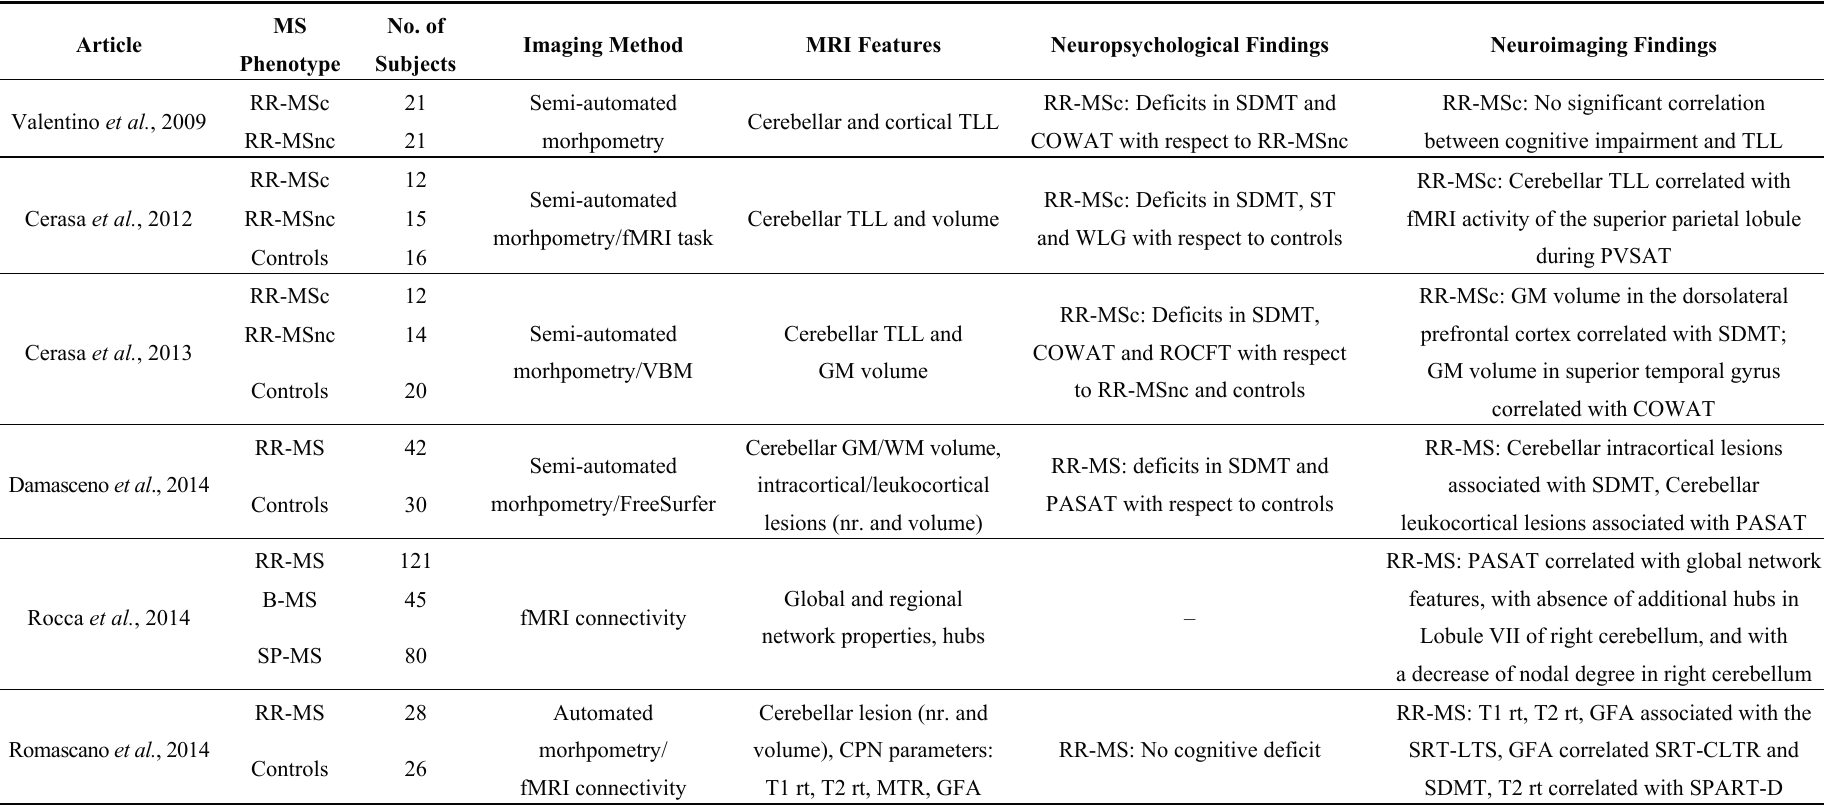
Table 1. Summary of works that found out a strong correlation between cerebellar abnormalities and cognitive impairment as measured by neuropsychological tests. For a list of abbreviation see Abbreviations